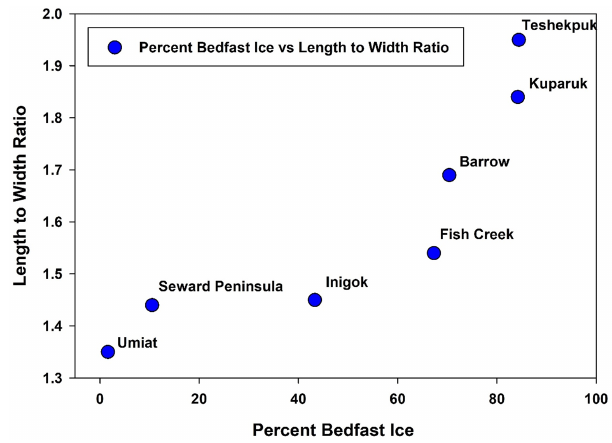
Figure 9. Comparison of length to width ratio versus the percent of a particular region exhibiting a bedfast lake ice regime for seven study areas in Arctic Alaska. This analysis is based on synthetic aperture radar (SAR) satellite remote-sensing data presented in En- gram et al. (2018). Lakes that are more elliptical in shape tend to occur where the majority of the lakes in the area freeze to their bed and thus likely do not have a talik. Lakes that are more circular in shape tend to occur where the majority of lakes in an area do not freeze to their bed and thus likely have a sub-lake